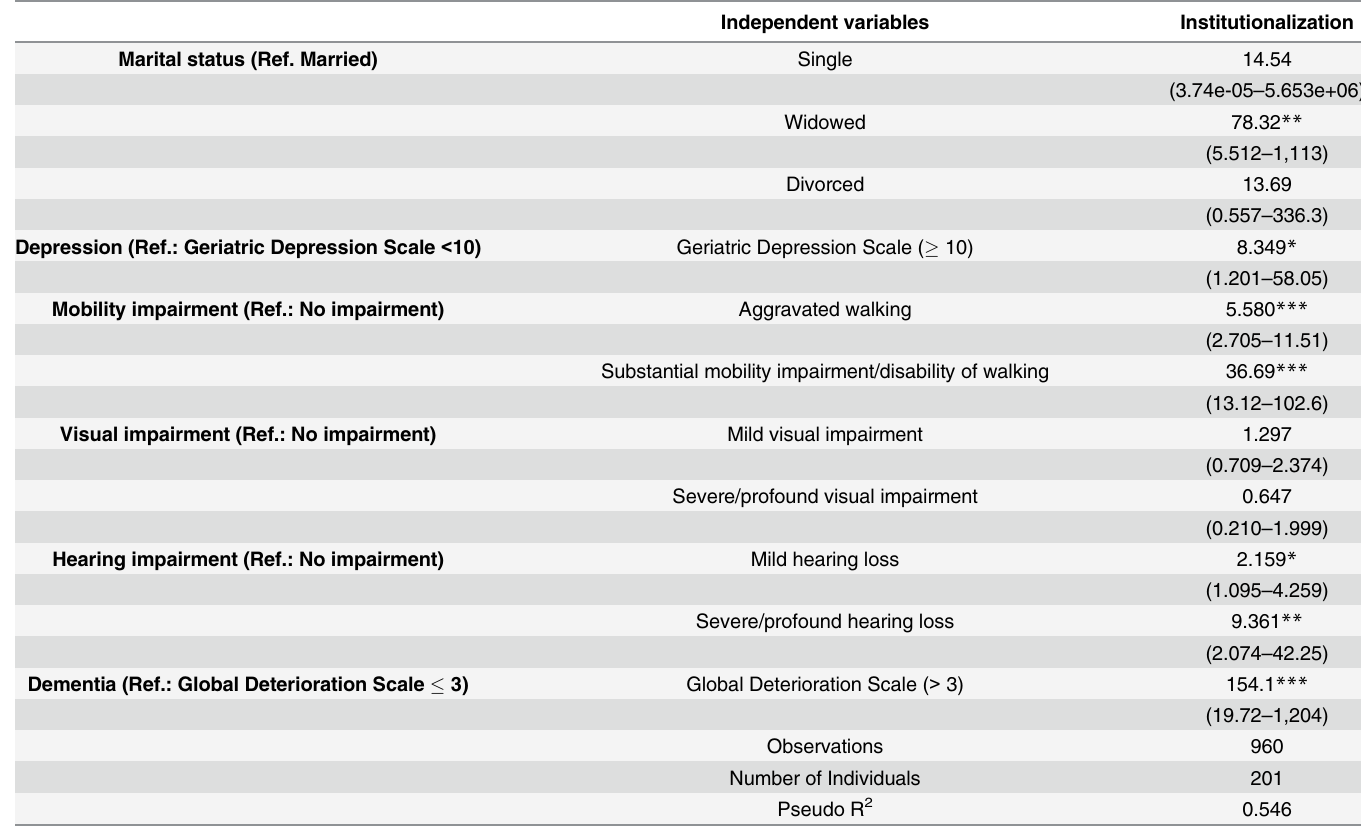
Table 2. Longitudinal predictors of institutionalization: Results of conditional fixed effects logistic regressions (Odd ratios